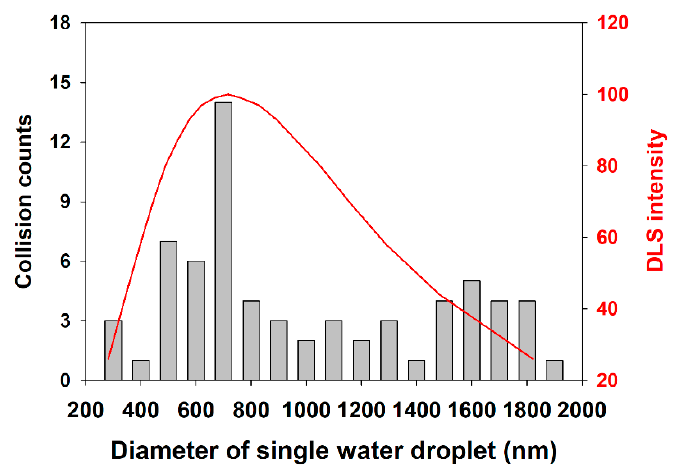
Figure 4. The size distribution of water droplets was obtained from the collision method (bars) and DLS measurements (red